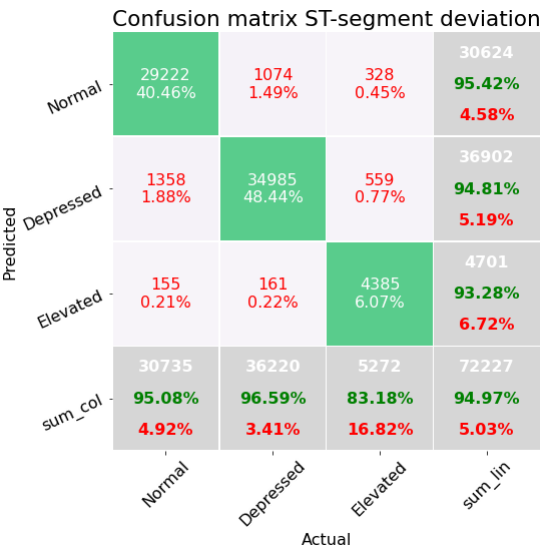
Figure 6. Confusion matrix on the modeling containing the features concerning statistical measures, distance from the baseline to J-point, and SQI of the beat ECG.